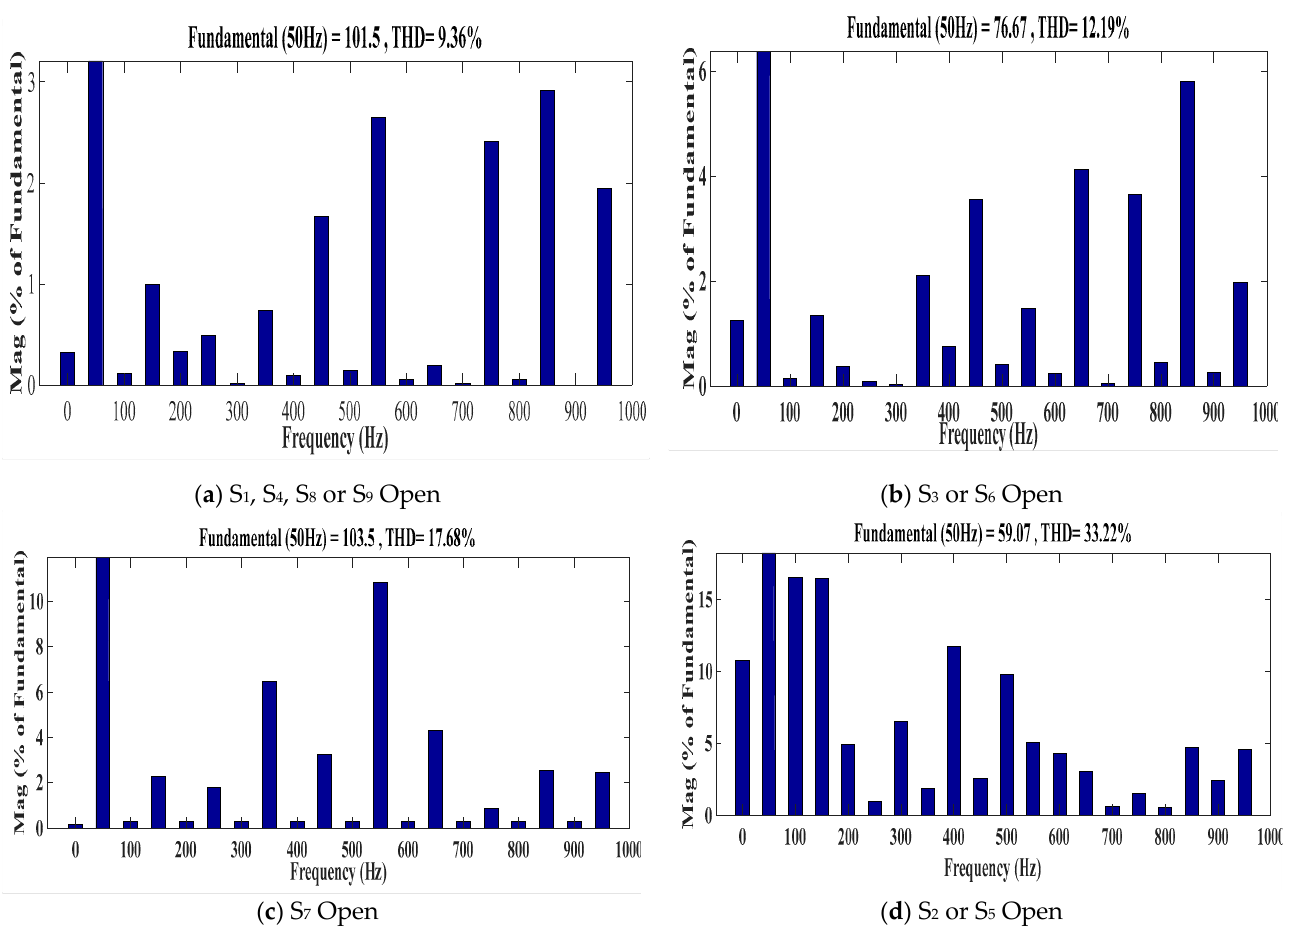
Figure 8. Simulation results of Voltage THD profiles after clearing of faults in ( a ) S 1 , S 4 , S 8 or S 9 ( b ) S 3 or S 6 ( c ) S 7 , and ( d ) S 2 or S 5 .